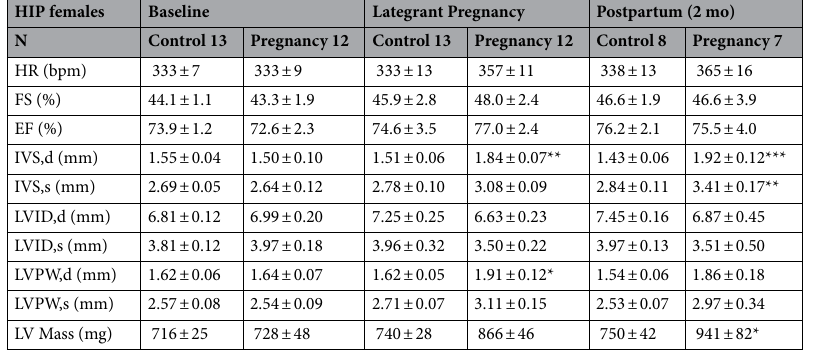
Table 2. Echocardiography parameters in HIP females from control and pregnancy groups. Measurements were performed at baseline, during late pregnancy and two months after giving birth. * P < 0.05, ** P < 0.01, and *** P < 0.001 vs. control